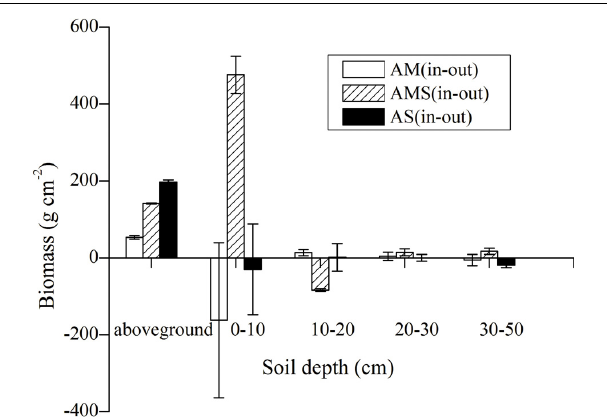
FIGURE 1 | Biomass distribution in the vertical direction between enclosed and grazed sites with three vegetation types: alpine meadow (AM), alpine meadow steppe (AMS), and alpine steppe (AS). Error bars were the standard error of three replicates’ biomass difference between enclosed and grazed area at corresponding